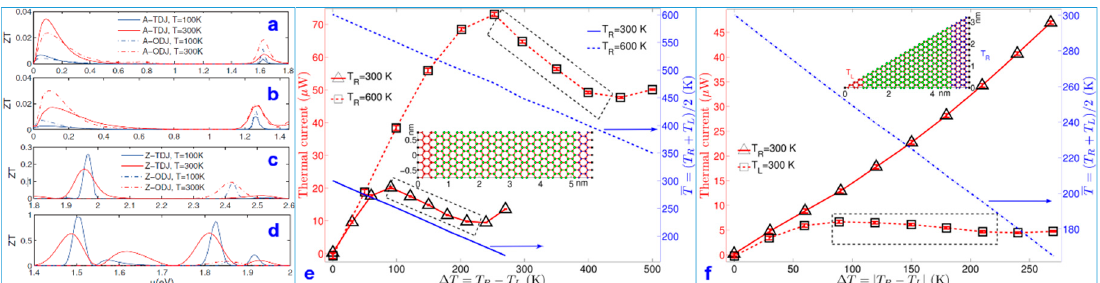
Figure 13. The figure of merit ZT at the two different temperatures of 100 K and 300 K in ( a ) and ( b ) for armchair edge junctions and ( c ) and ( d ) for zigzag edge junctions. Thermal current (left vertical axis) and average temperature (right vertical axis) vs. temperature difference ∆ T [106]. Copyright 2012, American Physical Society. The dashed boxes highlight negative differential thermal conductance (NDTC) in ( e ). The inset shows the structure of the GNR (1.5 nm × 6 nm). ( f ) Thermal current (left vertical axis) and average temperature (right vertical axis) vs. temperature difference ∆ T in triangular GNRs is shown in the inset. The dashed box highlights NDTC [107]. Copyright 2011, American Physical Society.